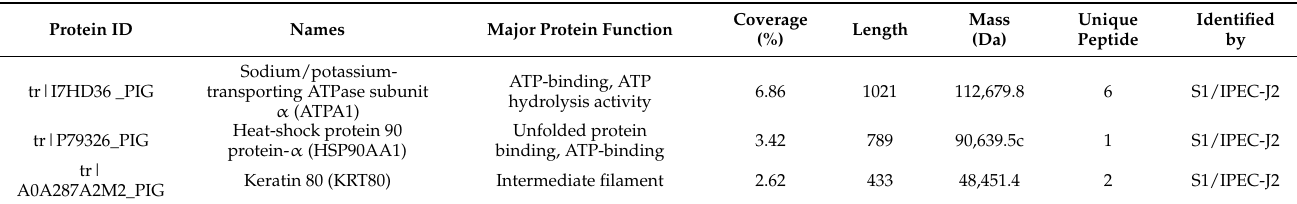
Table 1. Characteristics of differentially interacting proteins identified in PEDV S1 with the plasma membrane protein of Vero or